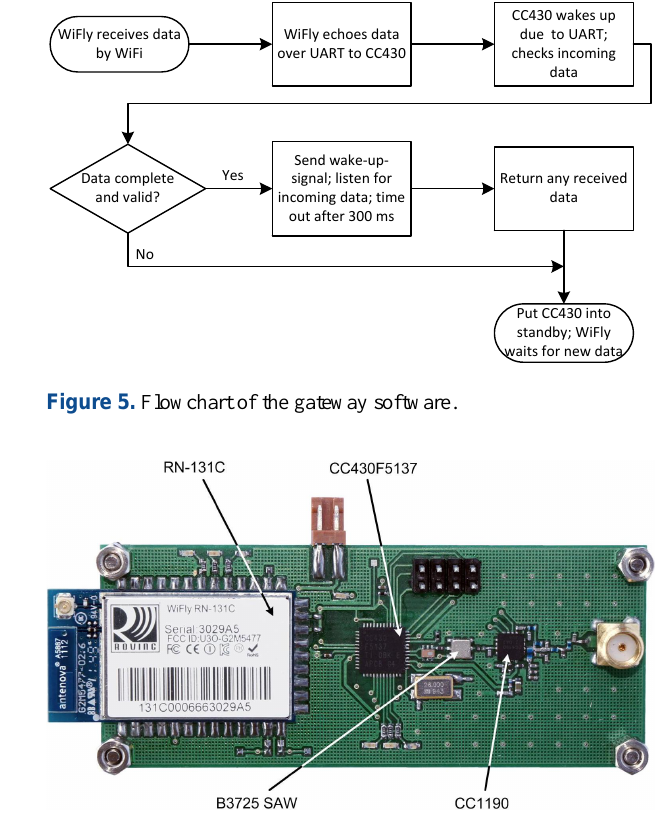
Figure 6. Photo of the assembled SmartGate.